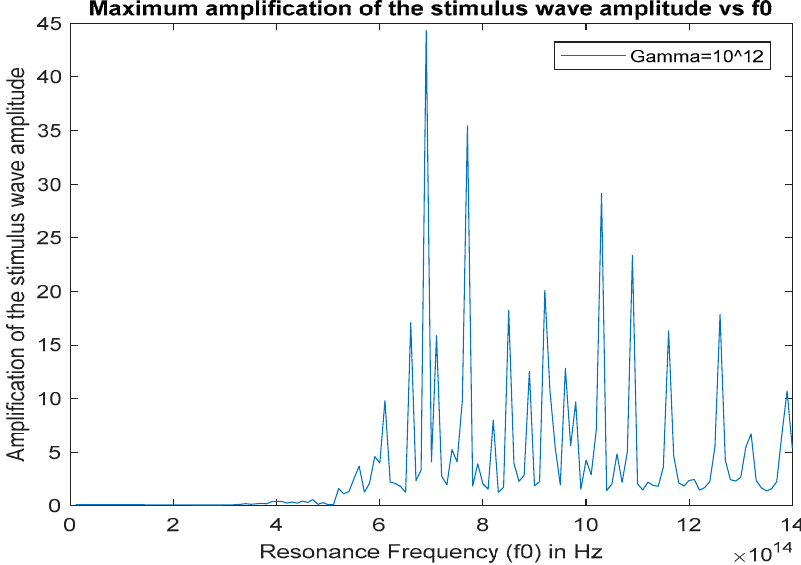
Figure 10. Maximum stimulus wave amplitude (gain factor) inside the cavity at x = 5.73 µ m for 0 < t < 30 ps, γ = 1 × 10 12 Hz, versus f 0 . The amplification for 𝛾 = 10 (cid:2869)(cid:2871) Hz is almost insignificant as shown in Figure 11. At this damping